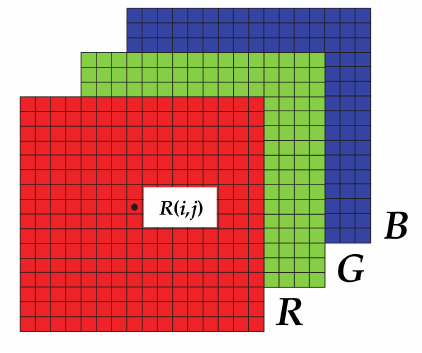
Figure 1. Data structure of RGB